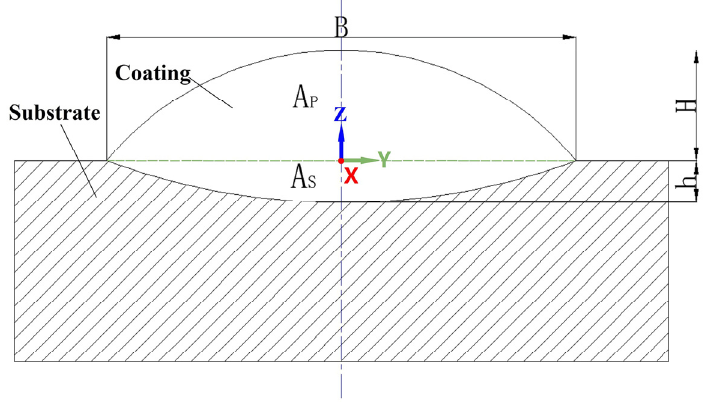
Figure 2. Typical geometry characteristics of the monolayer coating cross-section (B, H, h, A P , A S ).